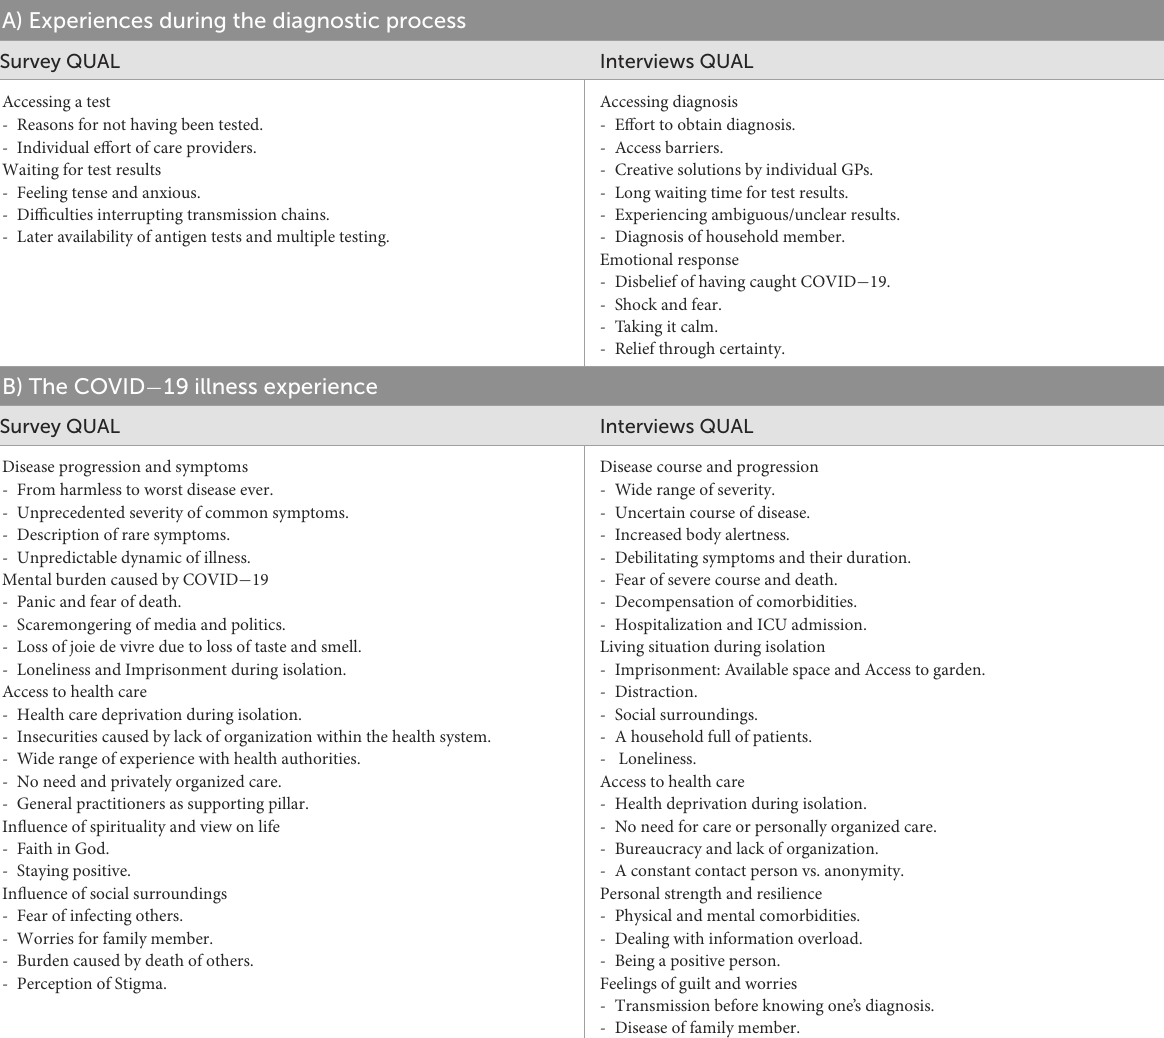
TABLE 3 Experiences of people affected by acute COVID − 19, summary of qualitative results. A) Experiences during the diagnostic process Survey